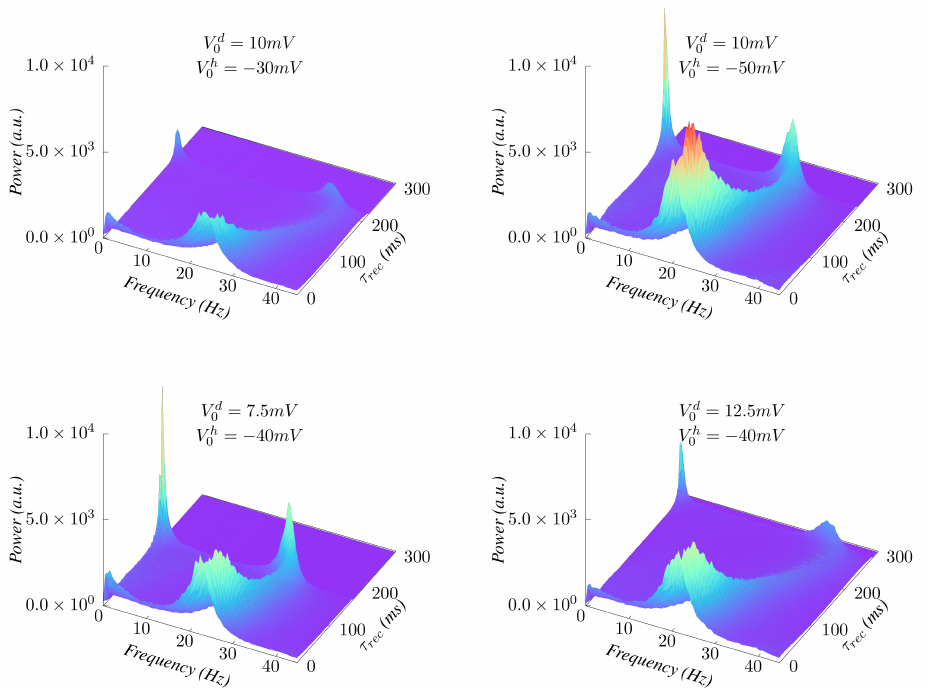
Figure 7. Effect of varying the E/I amplitude ratio as depression increases. ( Top ) Increasing the amplitude of I’s while leaving the E’s unchanged enlarges the δ / θ component of the δ ( θ ) − γ modu- lation around the phase transition ( τ rec ≈ 230 ms). ( Bottom ) Increasing the E’s while maintaining the I’s moves the transition point to higher levels of depression and makes the frequency of the emergent oscillations more sensitive to synaptic